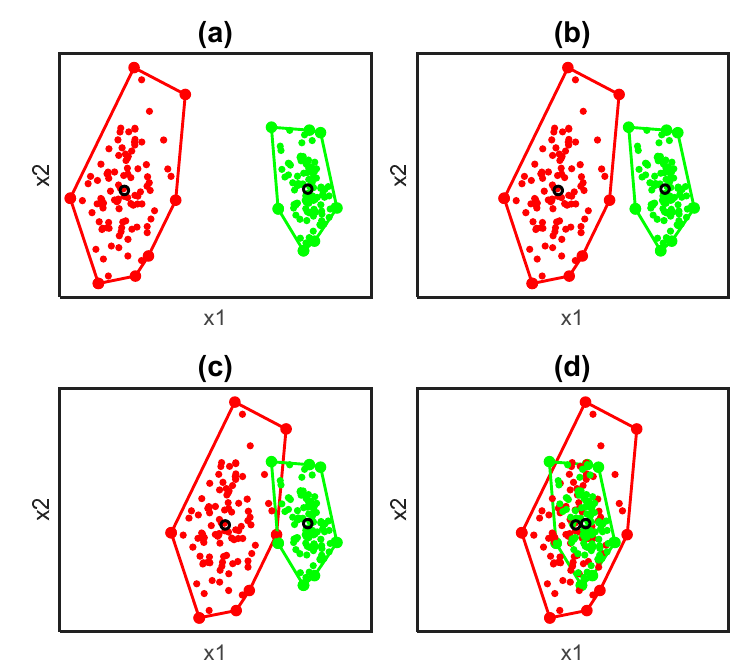
Figure 2. Examples of relative positions of the datasets containing “red” and “green” classes: ( a , b ) separation, ( c ) intersection, ( d ) merging.